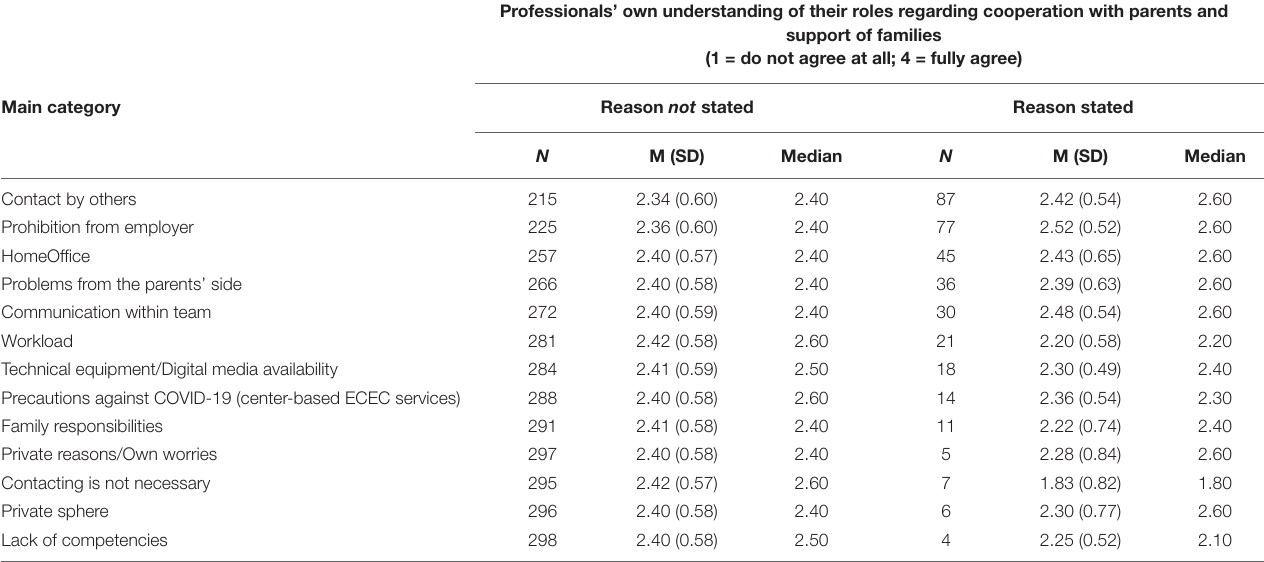
TABLE 6 | Differences in professionals role understanding within reasons for not being in contact with parents ( n = 302). Professionals’ own understanding of their roles regarding cooperation with parents and support of families (1 = do not agree at all; 4 = fully